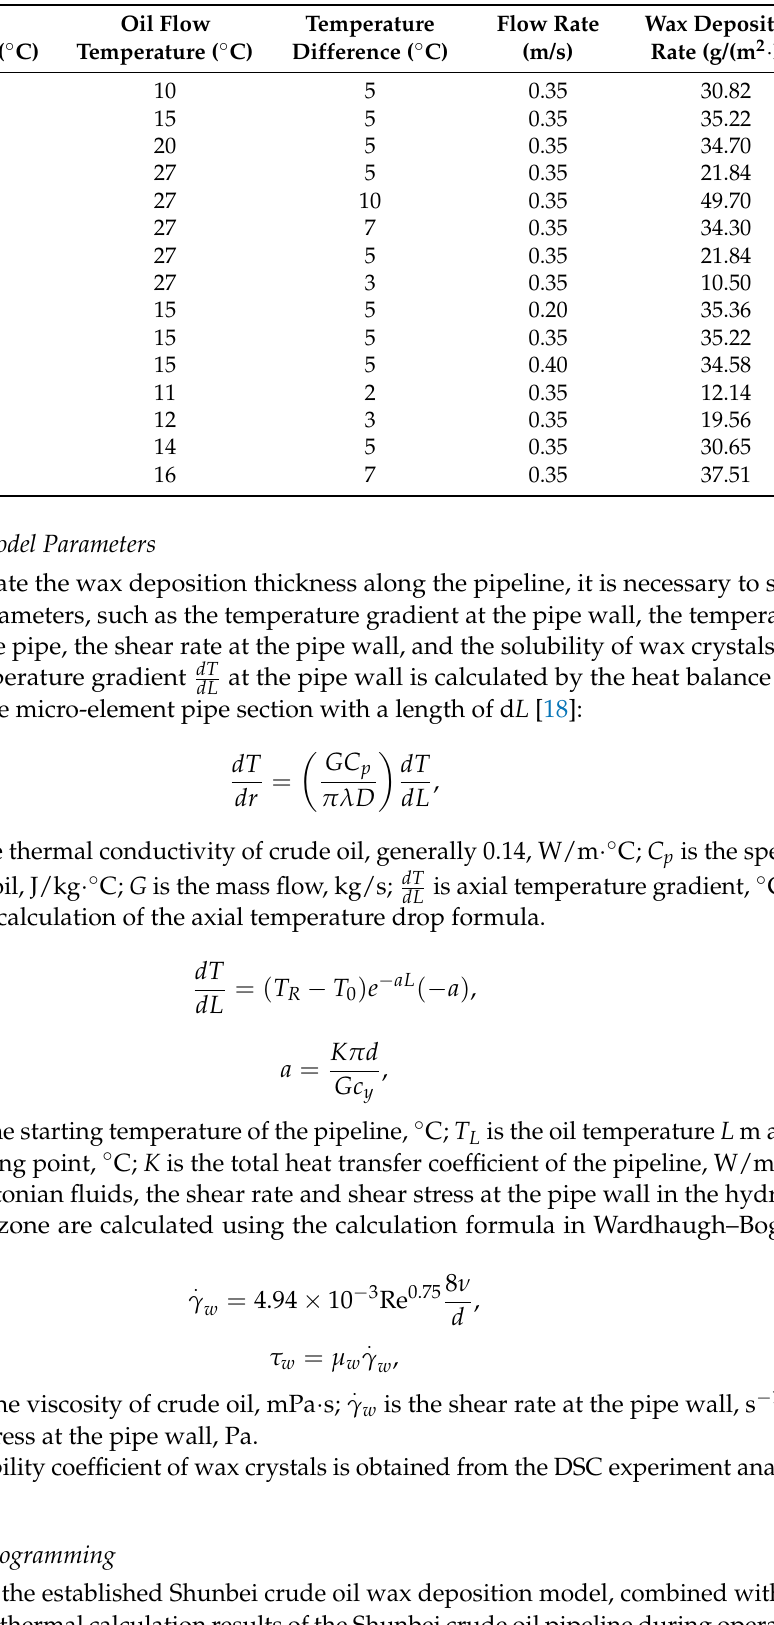
Table 3. Results of loop experiment of Shunbei crude